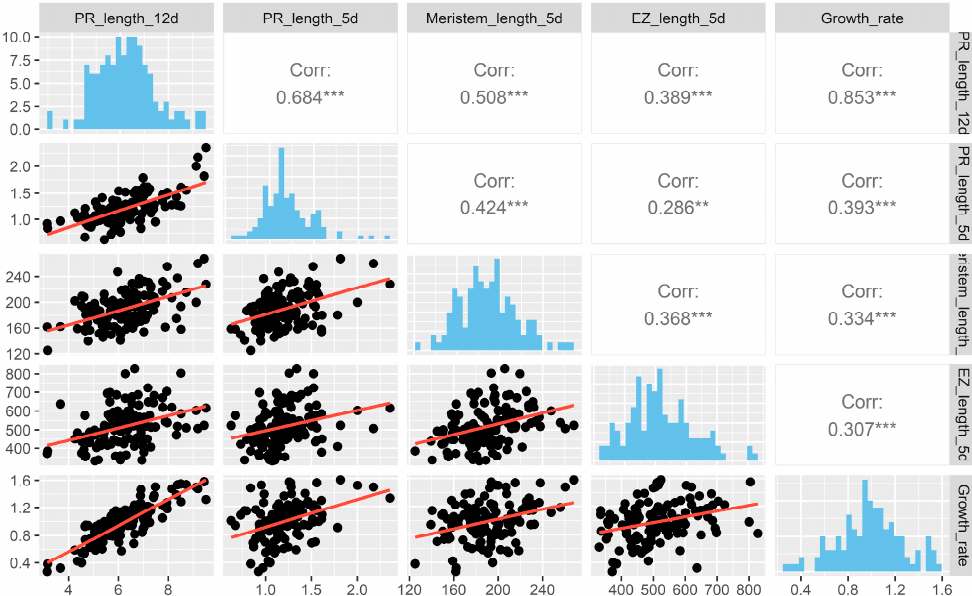
Figure 3. Pair plots between the four PR traits used in this study. The upper panel shows the correlation between the traits, the lower panel, the scatter plots of the traits and on the diagonal, the histograms. PR length was analyzed at 5 and 12 dps. Significant value is indicated (***) p <